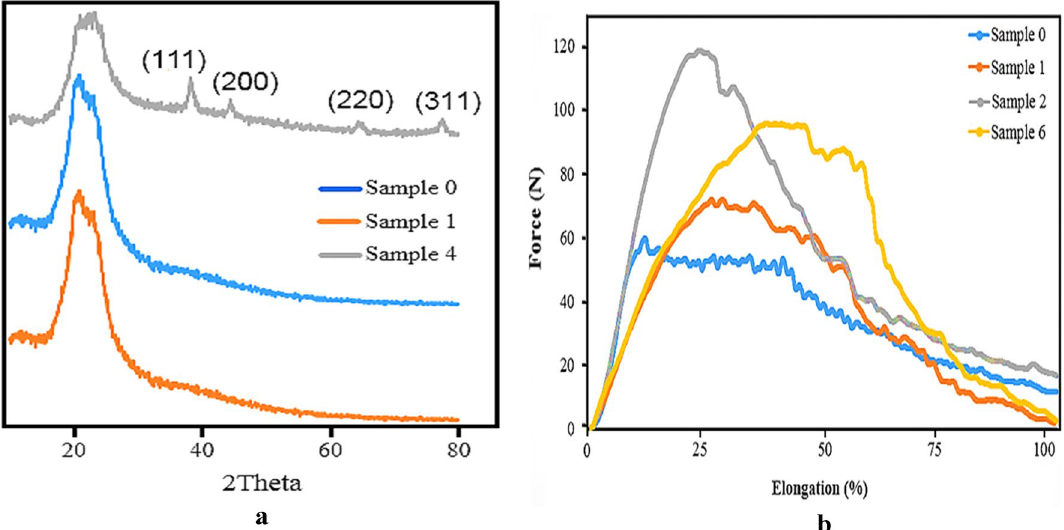
Figure 5. XRD patterns ( a ) and mechanical properties ( b ) of the uncoated and coated fabrics. Sample 0 (Uncoated fabric), Samples 1, 2, 4 (NS-coated fabrics at 2, 10, and 50 mM silver nitrate concentrations, and 25 min sonication time, respectively), Sample 6 (NS-coated fabrics at 10 mM silver nitrate concentration and 50 min sonication